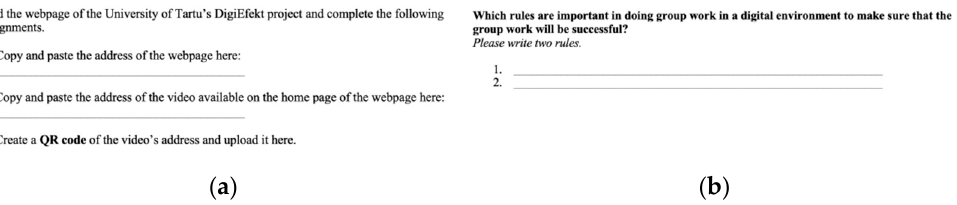
Figure 3. Sample items from the Digitest translated into English: ( a ) a test item for assessing operational skills; ( b ) a test item for assessing communication skills in the digital world.